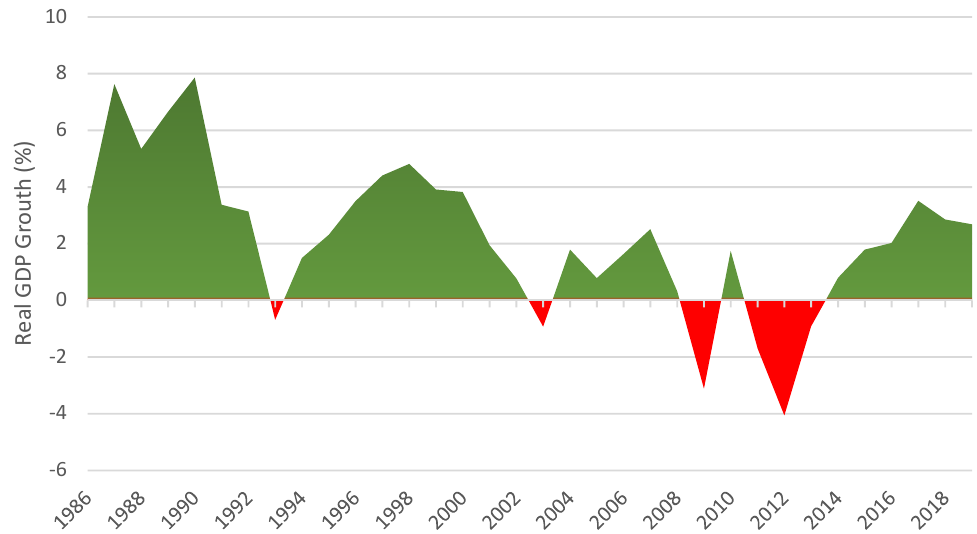
Figure 3. Real GDP growth in Portugal (1986–2018). Source: INE. In 2008 Lisbon was a city experiencing a decrease in households and total number of inhabitants, which, due to a stagnant economy in the 2000s and the ever-increasing prices of real estate properties in the city, were moving out to nearby municipalities, offering newly built dwellings with better conditions at much lower prices. However, the levels of indebtedness were also increasing, leaving households in much harder financial positions than in the 1990s. The rental market was also stagnant, due to the government’s rent freeze policies, leaving Lisbon with an old and unappealing city center.